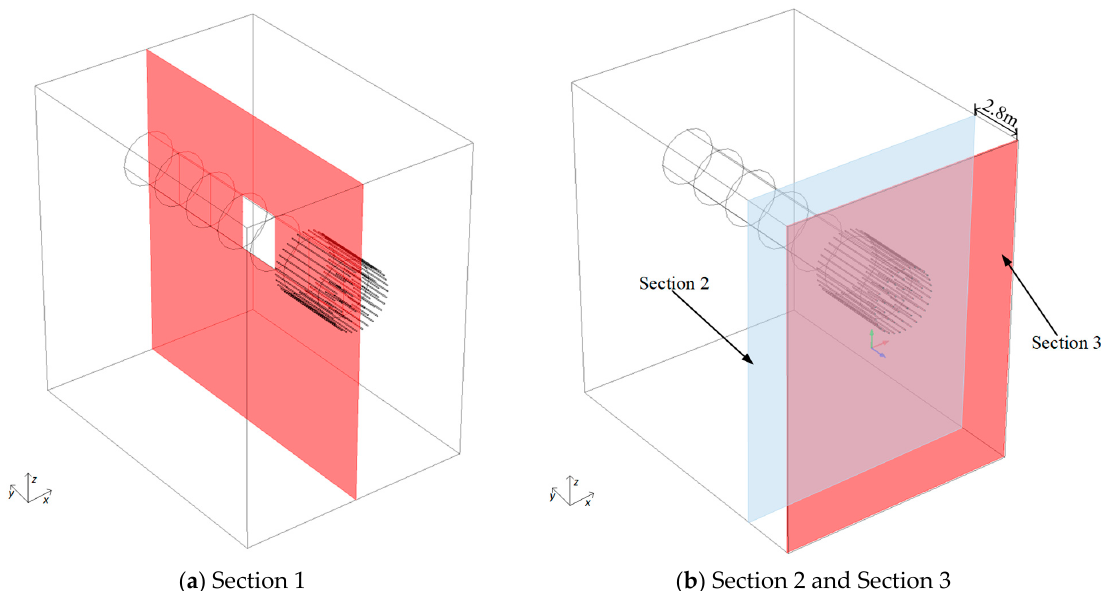
Figure 6. Location of critical sections.